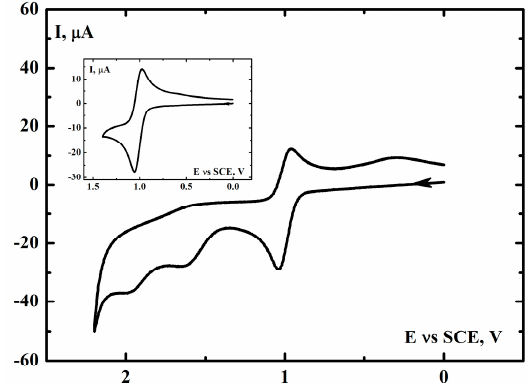
Figure 3. Cyclic voltammogram of 5mM [(N4Py)Fe II ] 2+ in MeCN containing 0.1 M ( t -Bu) 4 NClO 4 as a supporting electrolyte in argon atmosphere. Scan rate, 0.1 V ∙ s − 1 , GCE (0.008 cm 2 ), SCE vs. NHE +0.242 V. Inset, the anodic scan has been reversed after the appearance of the first